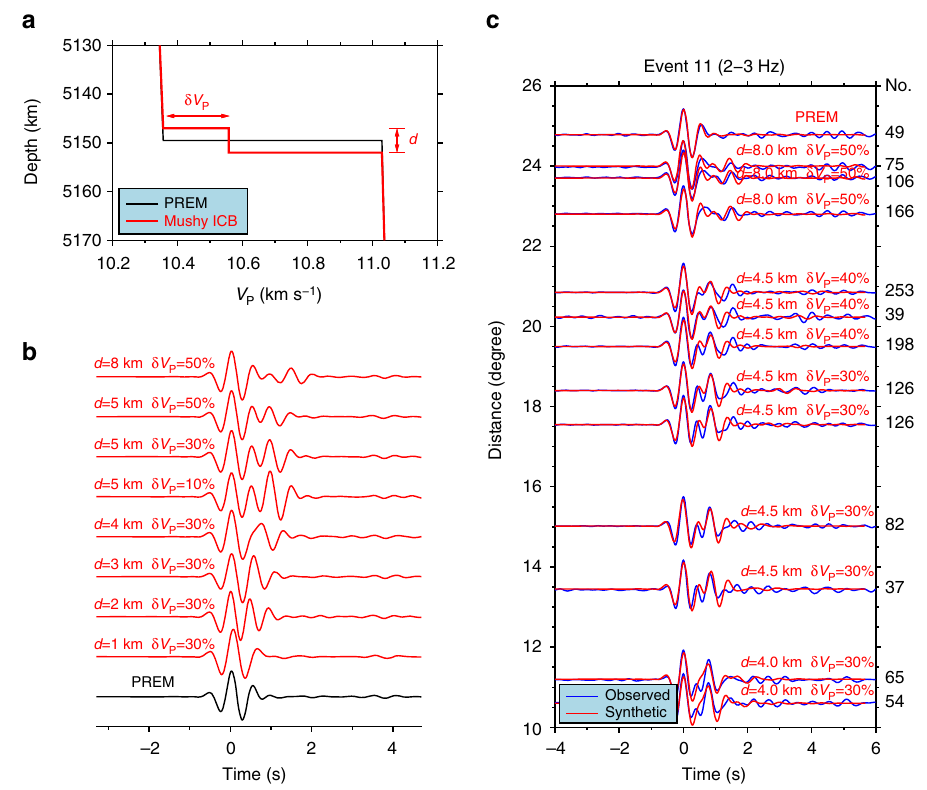
Fig. 4 Seismic model and waveform modeling for the PKiKP data sampling the ICB region beneath southwest Okhotsk Sea. a Compressional velocity pro fi le of the best- fi tting double-layered model across the ICB ( red line ) represented by two parameters: d the thickness of the layer and δ V P percentage compressional velocity jump of the top layer with respect to PREM velocity jump at ICB, along with PREM ( black line ). b Synthetic seismograms in a frequency range of 2 – 3 Hz for a series of double-layered ICB models ( red traces , labeled accordingly with two model parameters: d and δ V P ) and for PREM ( bottom black trace ). c Comparisons of stacked observed PKiKP waveforms ( blue traces ) of event 11 in a frequency range of 2 – 3 Hz and synthetic seismograms ( red traces ) of the best- fi tting models. The number of waveforms used in each stacking is labeled at the right of each trace, while the thickness d and percentage compressional velocity jump of the top layer δ V P of the best- fi tting models are labeled above the red traces . The sampled ICB region also corresponds to Boxes B and A4 in Fig.